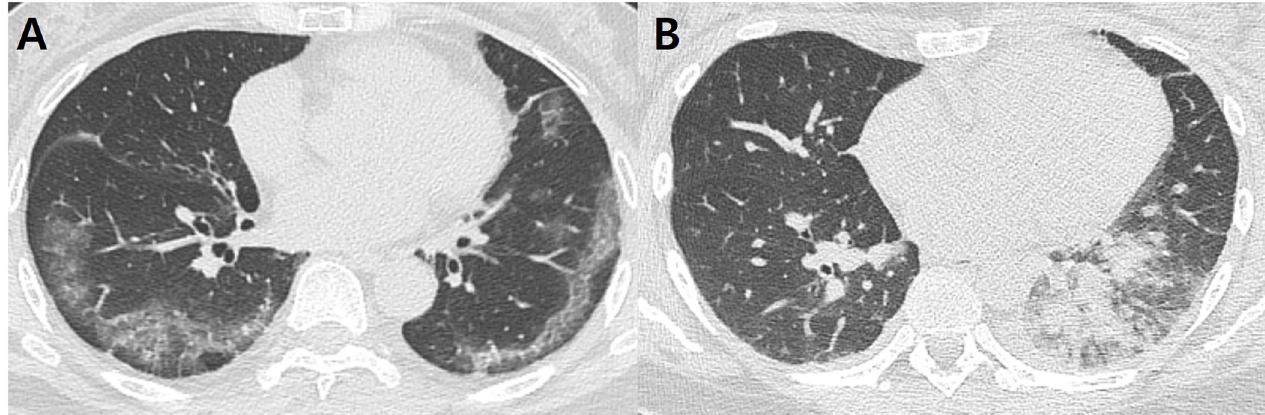
Fig 2. Representative cases of SARS-CoV-2 (A) and endemic HCoVs (B) pneumonia. (A) Pneumonia due to SARS-CoV-2 in a 63-year-old female. Axial computed tomography (CT) shows multifocal ground-glass opacities (GGOs), predominantly located in the peripheral areas of both lungs. (B) Pneumonia due to HCoV-229E in a 35-year-old female. Axial CT shows patchy and nodular consolidation and GGO in the left lower lobe. A small amount of pleural effusion is also present. https://doi.org/10.1371/journal.pone.0245547.g002 The coinfection status is presented in Table 4. No pathogen co-infected with SARS-CoV-2 pneumonia was identified, whereas 55% of endemic HCoV pneumonia cases had co-infected pathogens. The most common co-infected pathogens were Streptococcus pneumoniae (12.5%), Haemophilus influenza (12.5%), and influenza virus (10%).